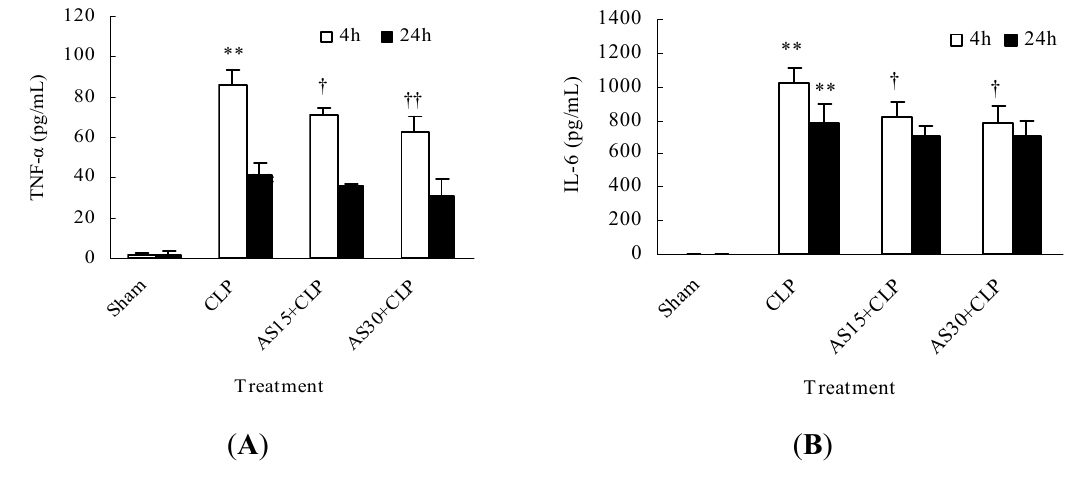
Figure 2. Effects of AS on serum TNF- α ( A ) and IL-6 ( B ) of CLP mice. Thirty-two mice were randomly divided into four groups ( n = 8). AS was repeatedly administered at 0 and 4 h after CLP operation. At 4 and 24 h after operation, four mice from each group were sacrificed, respectively. Sera were separated from the mice by centrifugation at 3500× g for 20 min and stored at − 80 °C for subsequent cytokine assays. TNF- α or IL-6 level was assayed using respective mouse ELISA kit. ** p < 0.01 as compared to Sham group; † p < 0.05, †† p < 0.01 as compared to CLP group. Other details are as described under Materials and